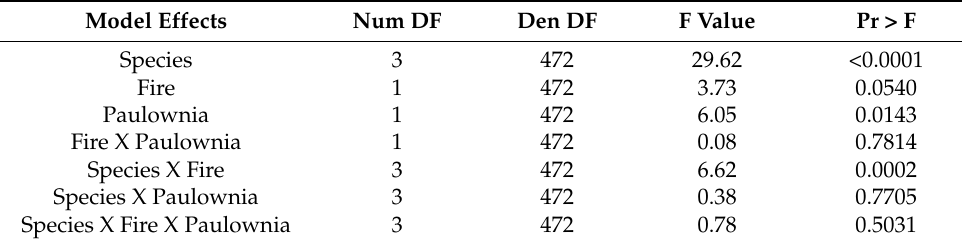
Table 2. The negative binomial model statistics for the main effects of species, fire (fire/no fire), paulownia (presence/absence) and their interactions to predict the number of stems per hectare for all native species studied